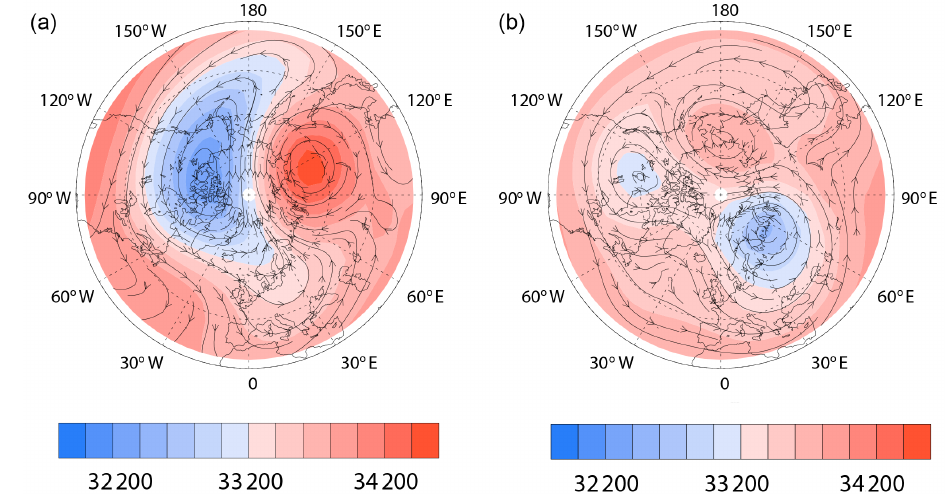
Figure 6. Geopotential (colours, given in gpm) and horizontal winds (streamlines, given in ms − 1 ) for the SSWbox (left) and SSWzon (right) simulation at the 13th model level (6 . 25hPa) at 280h after the